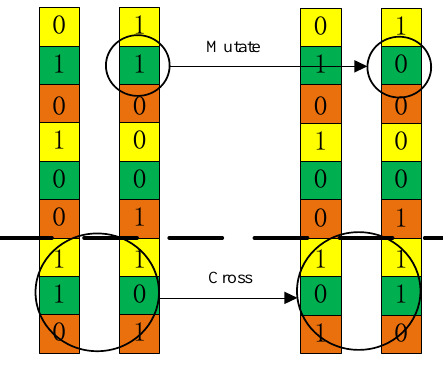
Figure 5. Cross and mutation principle of genetic